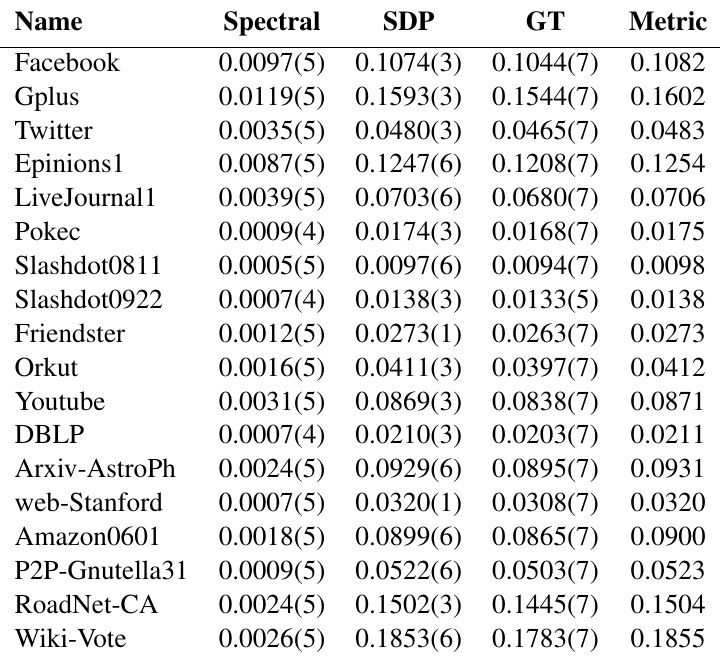
Table 3. Comparison of our approaches with other best methods in terms of conductance; the numbers inside the brackets denote the algorithm of the group.